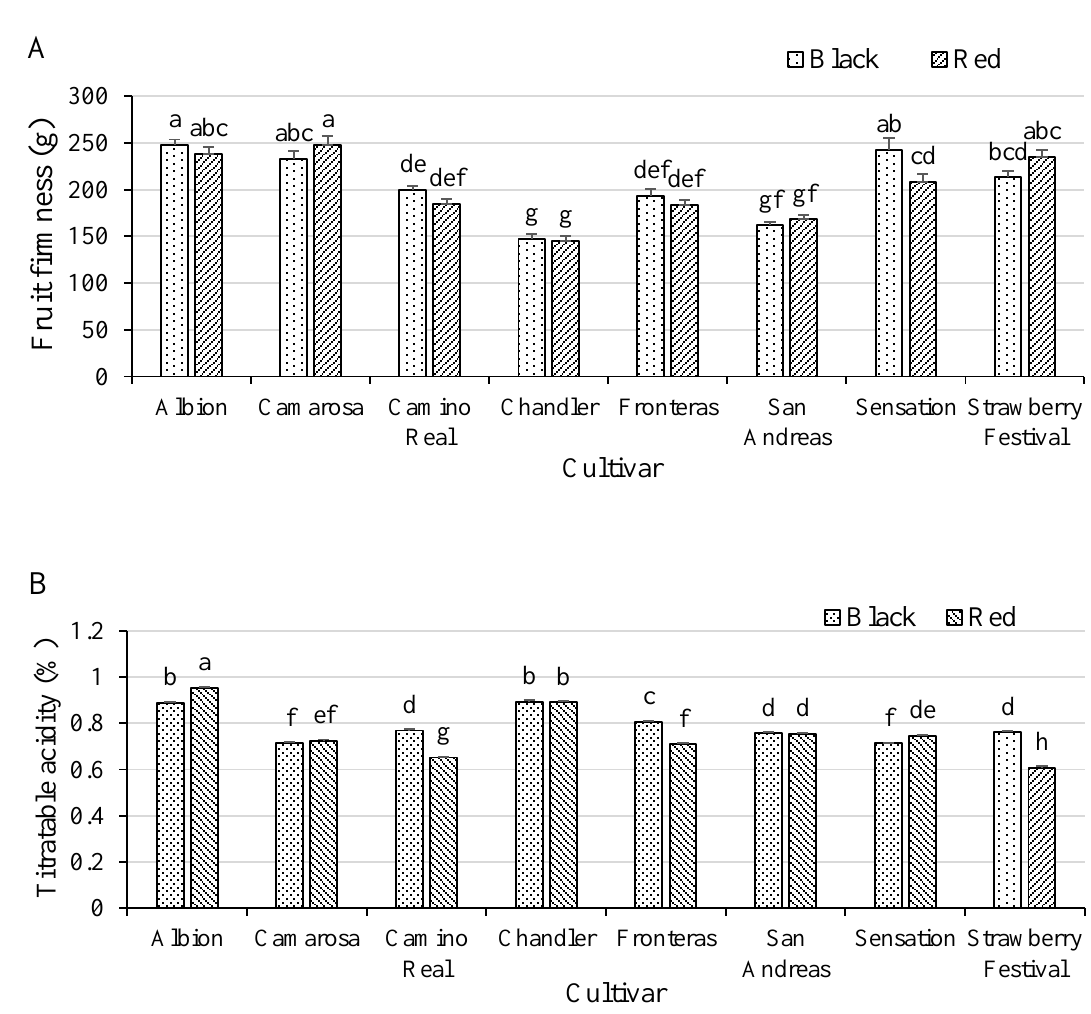
Figure 6. Strawberry fruit firmness ( A ) and titratable acidity ( B ) affected by the interaction between cultivar and mulch type grown in a high tunnel in Starkville, Mississippi from November 2017 to June 2018. Six June-bearing (“Camarosa”, “Camino Real”, “Chandler”, “Fronteras”, “Sensation”, and “Strawberry Festival”) and two day-neutral (“Albion” and “San Andreas”) strawberry cultivars were grown with black or red plastic mulches in a high tunnel production system. Different lowercase letters on top of each bar indicate a significant difference among all treatment combinations using Tukey’s HSD test at p ≤ 0.05.